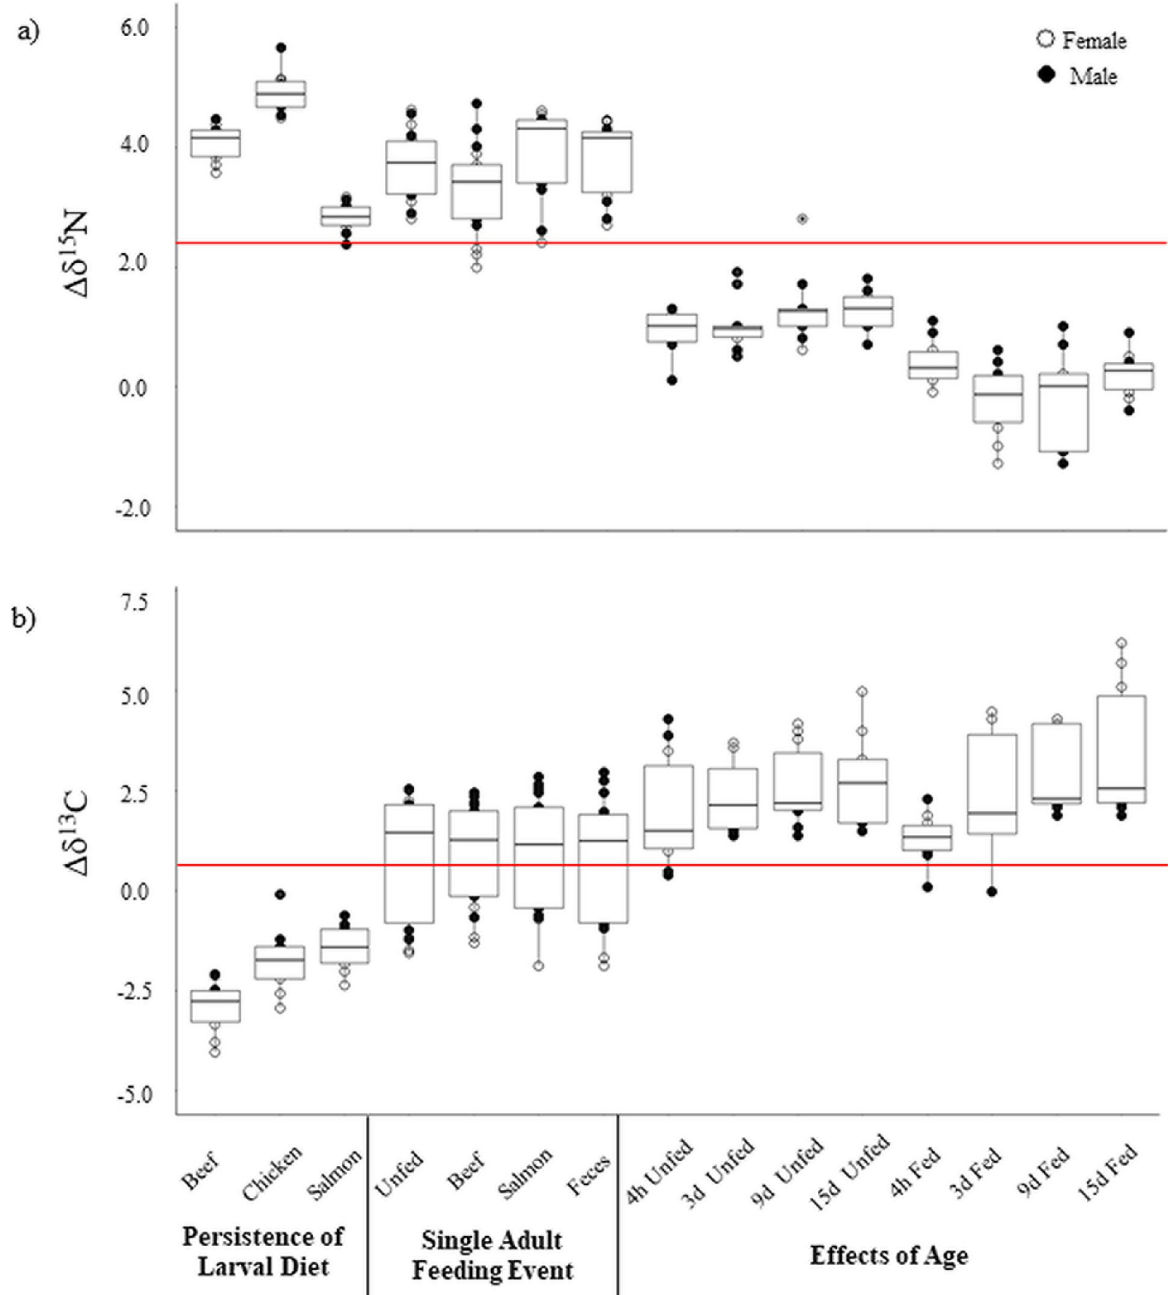
Fig 2. Boxplots summarizing the fractionation values for all experiments. Mean nitrogen fractionation ( Δδ 15 N; panel A) and mean carbon fractionation ( Δδ 13 C; panel B) are illustrated for each treatment across experiments. Open circles represent females and closed circles represent males. The red line indicates the mean value for both Δδ 15 N and Δδ 13 C across all experiments.